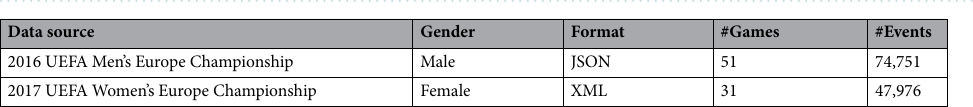
Table 1. Data sources’ specifications. Gender of the games included, data provider, the data format of the files, number of games, and number of events